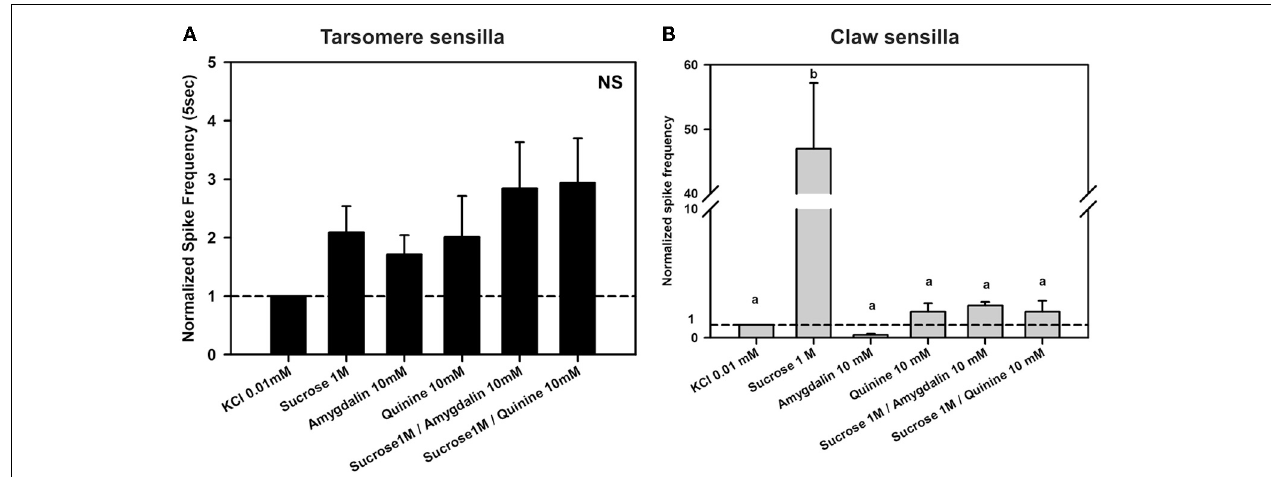
FIGURE 8 | Experiment 6. (A) Chaetic sensilla of the 3rd and 4th tarsomeres. Mean normalized spike frequencies ( ± SE) obtained upon stimulation with the different tastants assayed. Responses (action potentials per second) were normalized to those recorded for KCl 0.01mM (hatched horizontal line). Data were obtained from 12 tarsomere sensilla of 5 bees in response to the 6 stimuli assayed, each one being tested once ( n = 72). NS, non